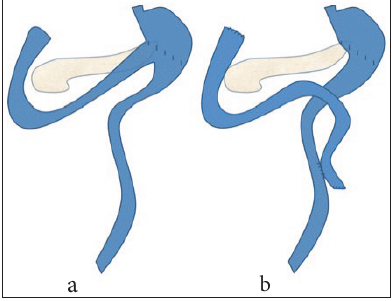
Fig. 4. (a) Bilroth II gastrectomy with gastro- jejunostomy. (b) Partial gastrectomy with Roux- en-Y jejuno-jejunostomy anastomosis.